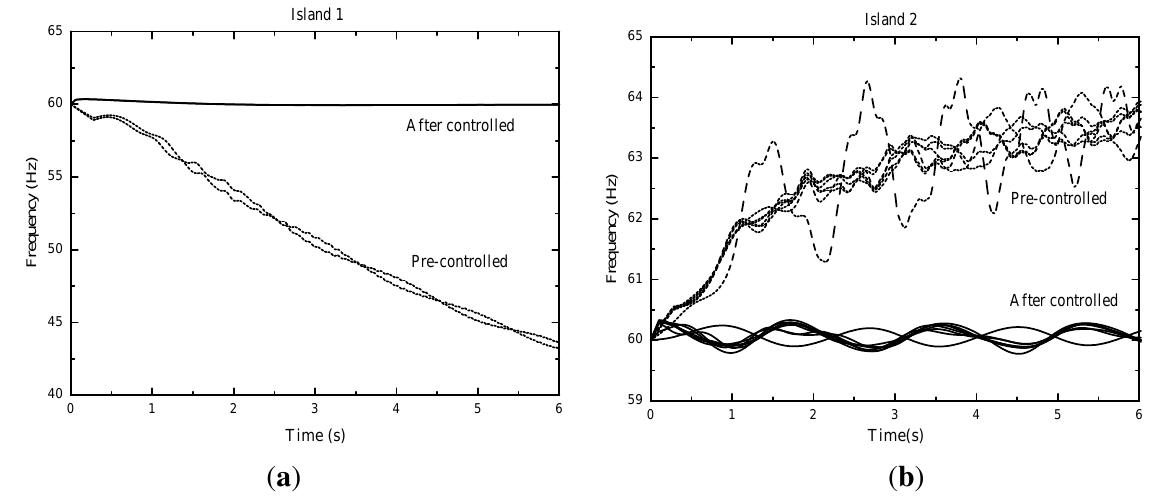
Figure 8. Generator frequencies in the island: ( a ) Island 1; and ( b ) Island